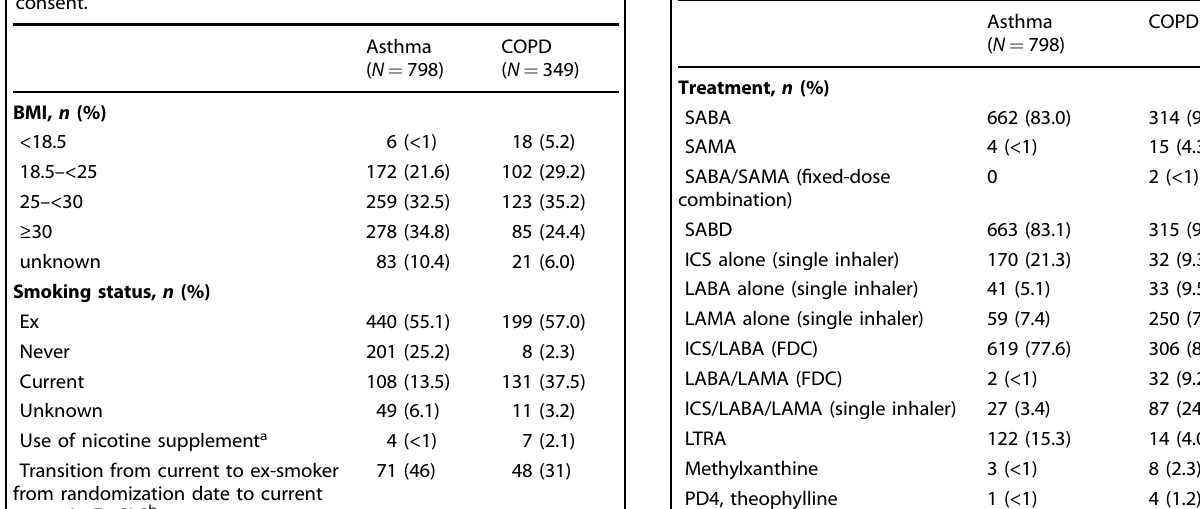
Table 7. Respiratory medicines prescribed in the 12 months prior to Ext-SLS consent, as recorded in primary care